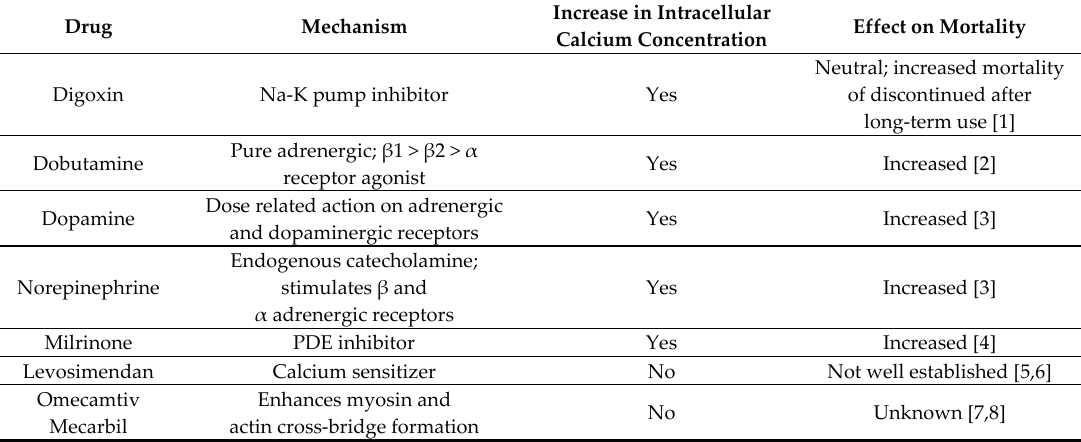
Table 1. Inotropic